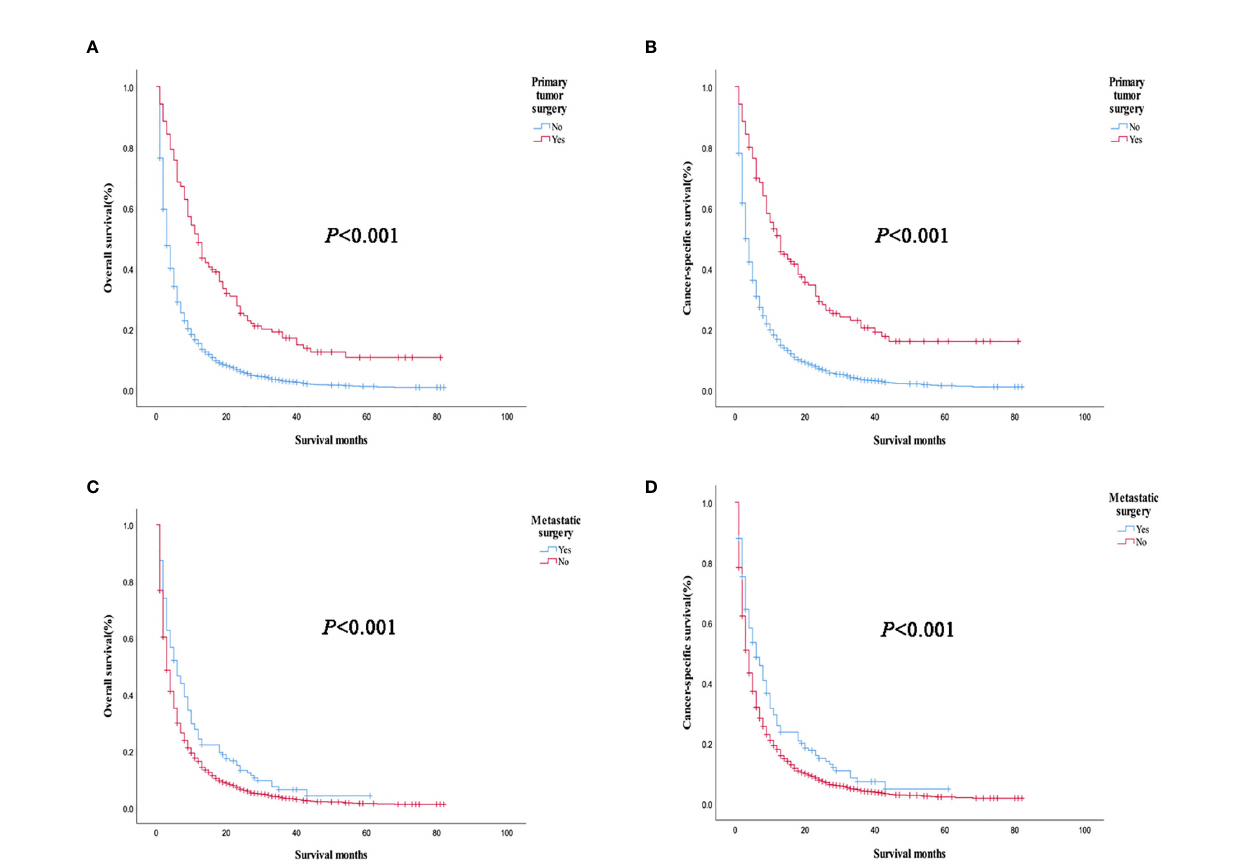
FIGURE 5 | Overall survival and cancer-speci fi c survival curves of primary tumors and metastatic tumors in all patients with organ metastasis. (A, B) Primary tumor surgery; (C, D) Metastatic